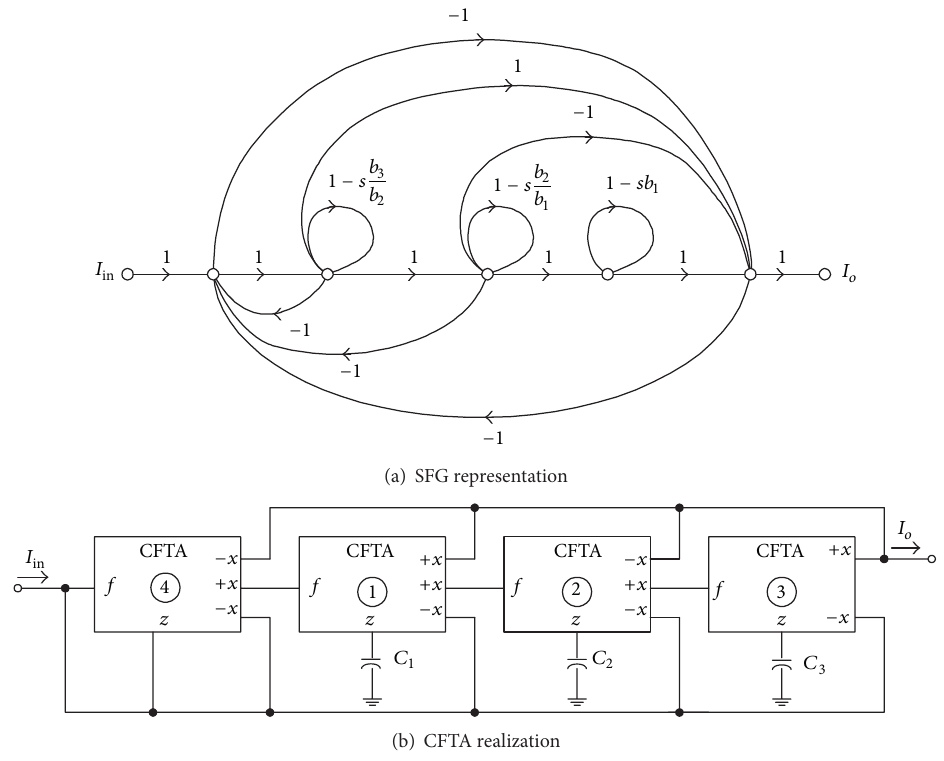
Figure 6: Third-order all-pass current transfer function of (10).